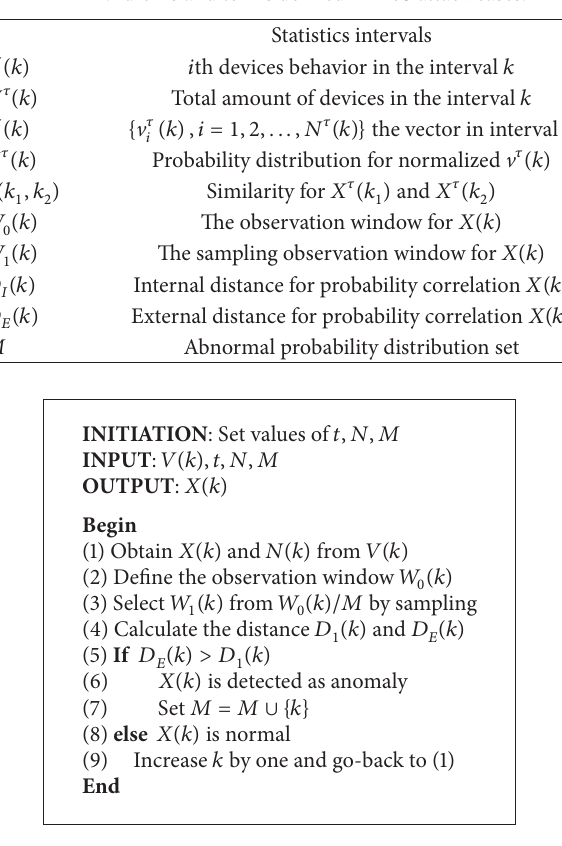
Algorithm 2: Pseudocode of abnormal behavior analysis for mobile